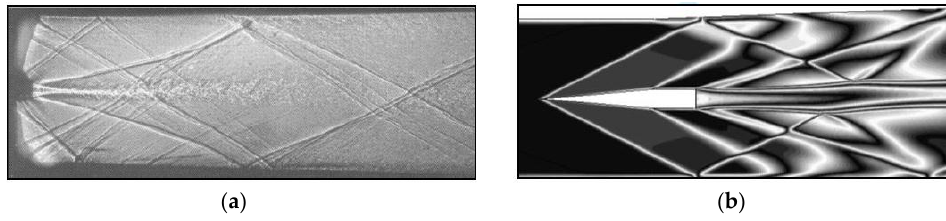
Figure 11. Cold flow comparison of DLR scramjet [12] Schlieren ( a ) to CFD test replication ( b ). Energies 2017 , 10 , 1900